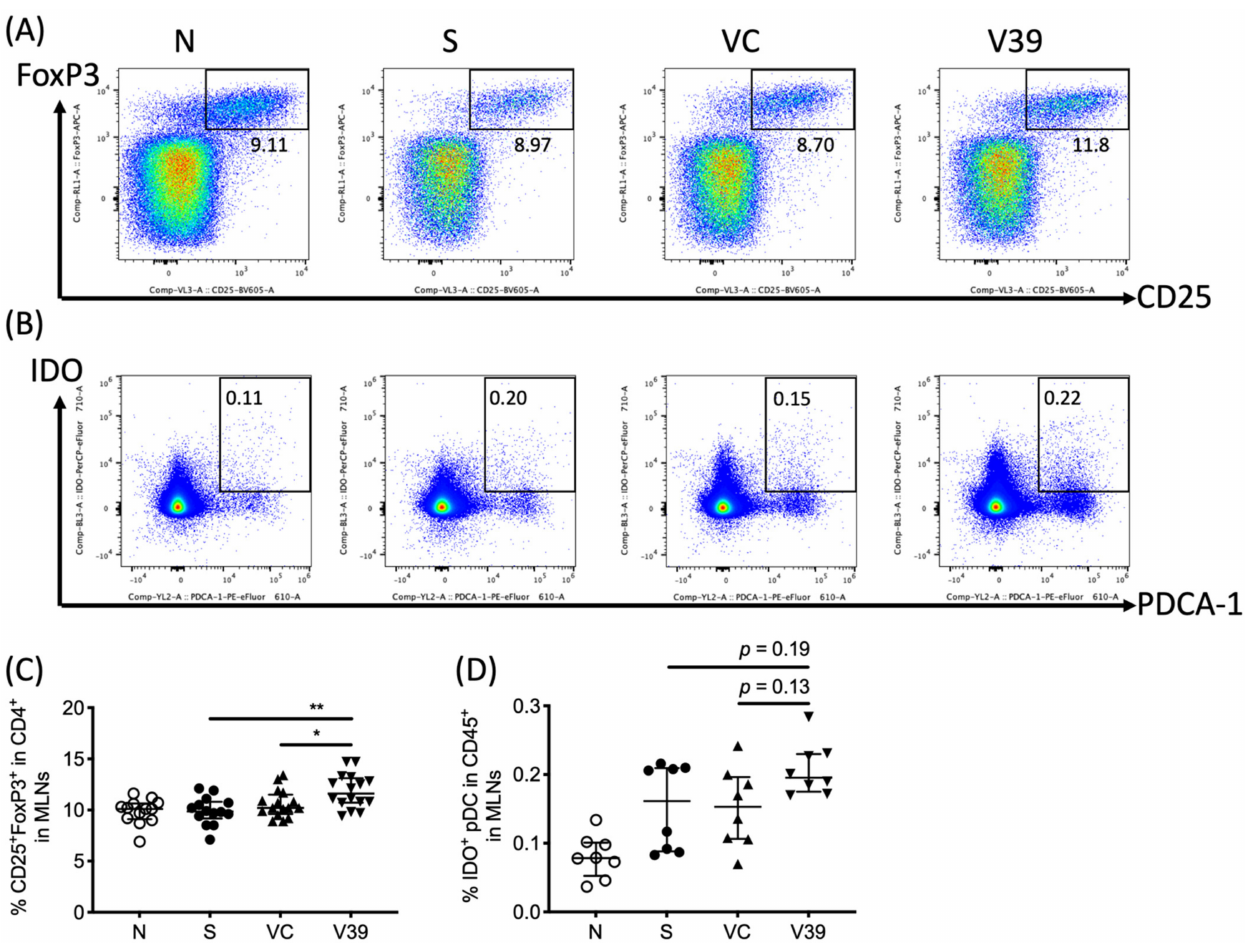
Figure 6. The frequency of CD25 + FoxP3 + CD4 regulatory T cells and tolerogenic dendritic cells were increased in draining lymph nodes. Leukocytes in mediastinal lymph nodes were suspended, and the representative flow plots of ( A ) CD25 + FoxP3 + cells in CD4 T cells and ( B ) indoleamine 2,3-dioxygenase (IDO) expressing plasmacytoid dendritic cells (pDC; PDCA-1 + ) in leukocytes were determined by flow cytometry. The quantitative data of ( C ) Tregs and ( D ) IDO + pDCs are shown in percentages. Data are presented as median with interquartile range (* p < 0.05, ** p < 0.01 in the comparison of V39 with S or